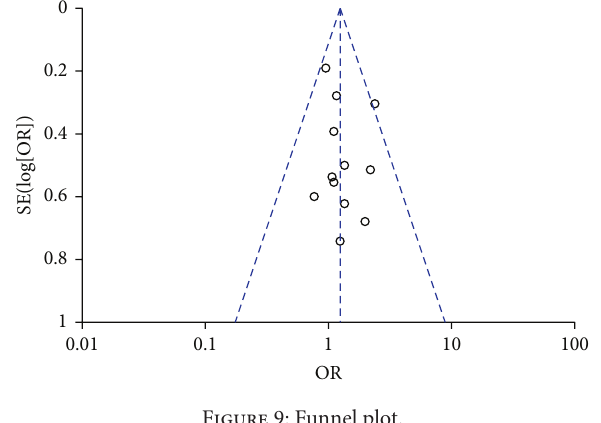
Figure 9: Funnel